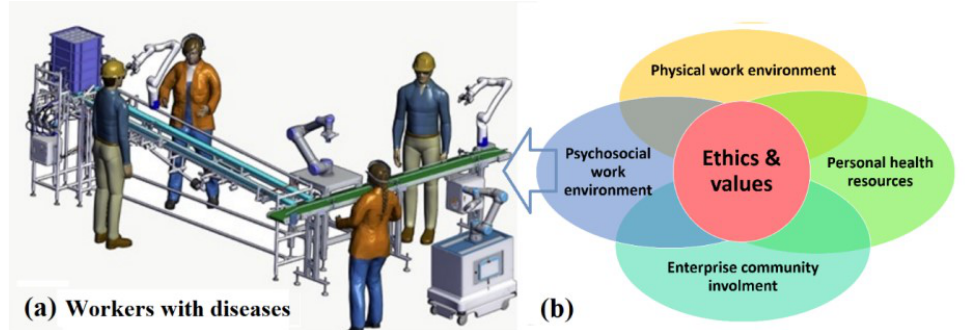
Figure 1. HUMANISE’s framework consists in the management of safety in Industrial Collaborative Robotics with workers suffering from disease conditions: ( a ) Industrial Collaborative Robotics (CoBot) scenario. ( b ) Worker’s health conditions through World Health Organization (WHO) workplace model [2].